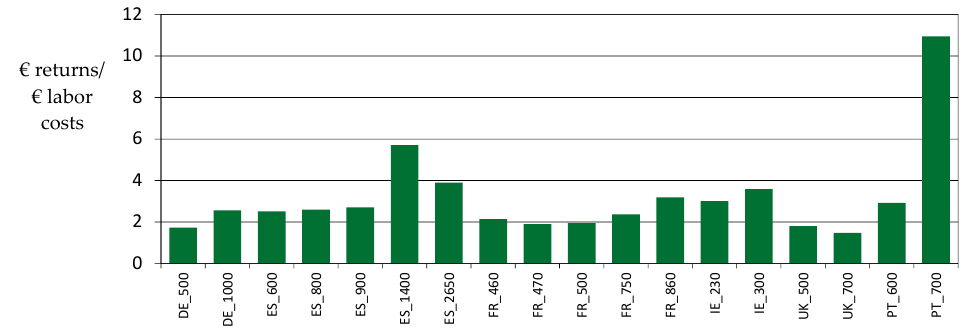
Figure 9. Economic labor productivity ( € returns / € labor costs). Source: model results.